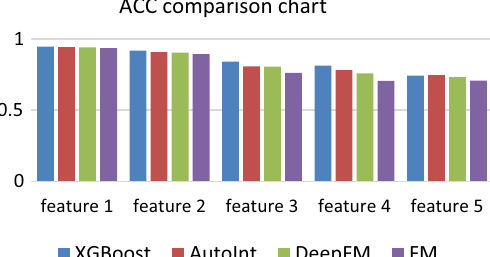
experimentFeature